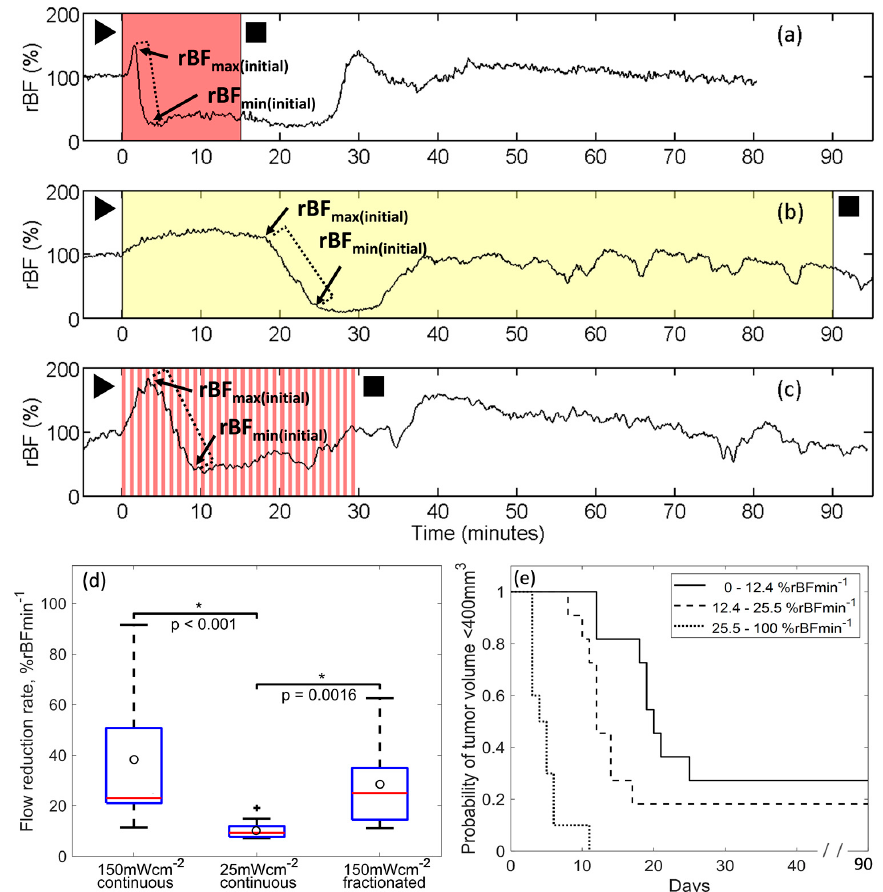
Figure 2. Representative blood flow traces during standard light delivery to radiation-induced fibrosarcoma (RIF) tumors using ( a ) 150 mWcm − 2 -continuous; ( b ) 25 mWcm − 2 -continuous; and ( c ) 150 mWcm − 2 standard fractionated illumination with 30 second light-on / light-o ff intervals. Light delivery is shaded in red or yellow for illumination at 150 mWcm − 2 or 25 mWcm − 2 , respectively. (cid:183) and (cid:4) indicate the initiation and completion of light delivery, respectively. rBF max(initial) and rBF min(initial) are the maximum and minimum that define the initial peak and trough in relative blood flow (rBF) during photodynamic therapy (PDT). A dotted bracket on each plot represents the slope of rBF decrease, i.e., flow reduction rate. ( d ) Box plots of blood flow reduction rate for standard PDT treatments (open circles indicate means; n = 10–11 mice per group). Statistical di ff erences between groups by Wilcoxon rank-sum tests with Holm-Bonferroni adjustment are indicated. * represents groups with statistically significant di ff erent flow reduction rates. ( e ) Kaplan-Meier survival curves for mice treated using standard PDT defined by tertiles of flow reduction rate ( n = 10–11 mice per group). P < 0.001 for global Gehan Wilcoxon test of di ff erences between irradiance levels; p < 0.001 for the 25.5–100% rBFmin − 1 group versus each lower group and p = 0.027 for 0–12.4% rBFmin − 1 versus 12.4–25.5% rBFmin − 1